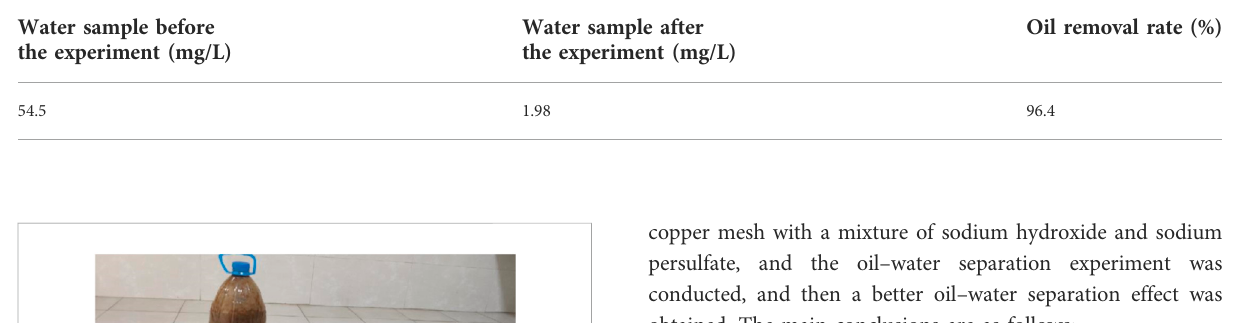
FIGURE 11 Comparison diagram of water qualities before and after